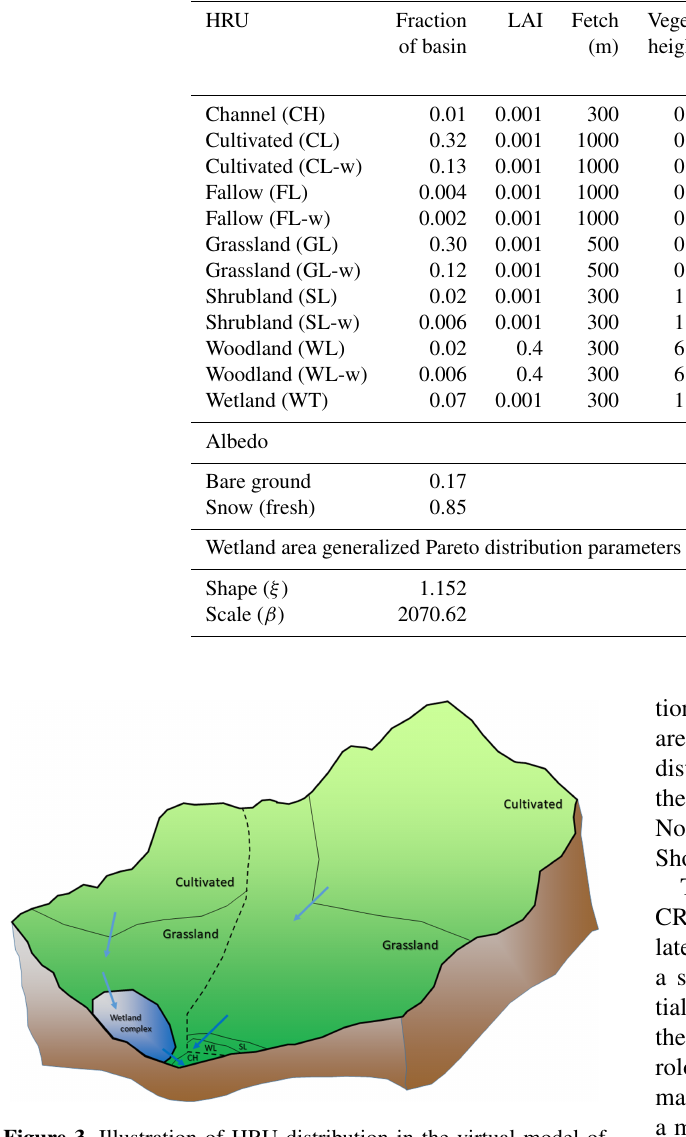
Figure 3. Illustration of HRU distribution in the virtual model of a typical High Elevation Grasslands basin. The illustration depicts two catenas, one with a wetland complex and one without, separated by the dashed line. Relative areas are meant to approximate those listed in Table 1. SL denotes shrublands, WL woodlands, and CH a channel HRU (see Table 1). The fallow and shrubland and woodland HRUs directed through the wetland complex are too small to be shown at this